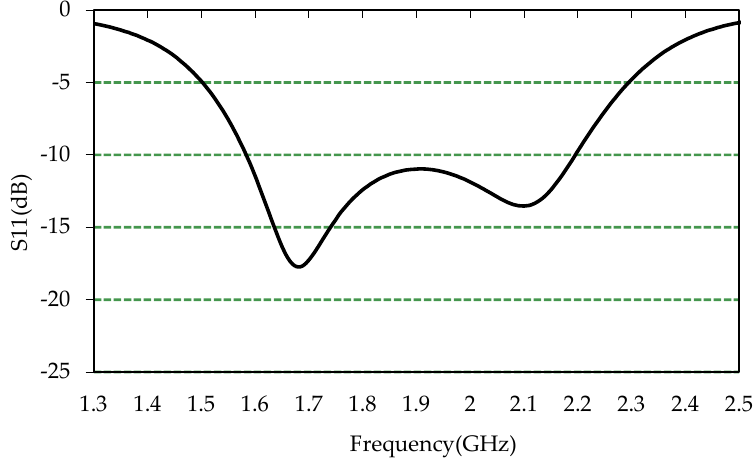
Figure 2. Simulated S 11 of the proposed antenna.